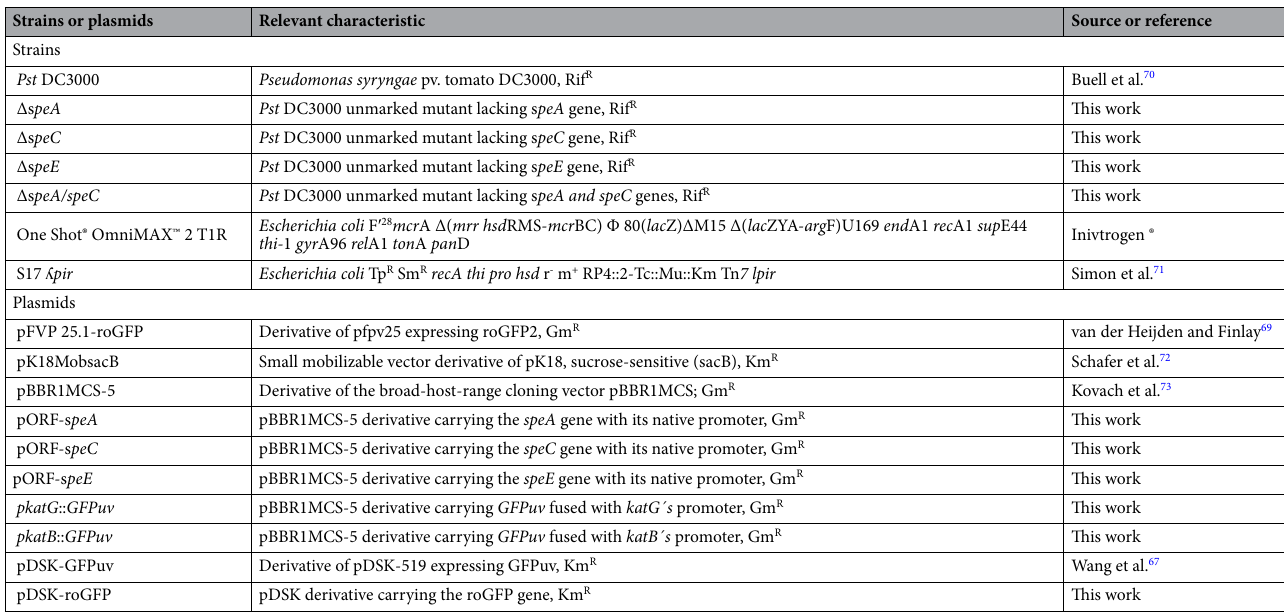
Table 1. Bacterial strains and plasmid used in this